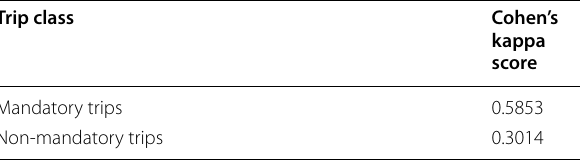
Table 7 Cohen’s kappa score for mandatory and non- mandatory